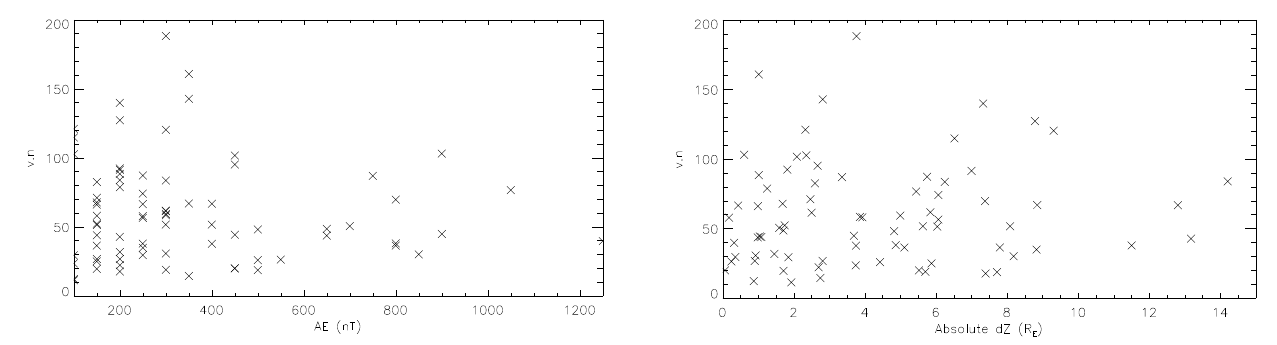
Fig. 17. The normal velocity component of the plasma sheet ex- pansions plotted against average AE conditions to test for substorm size dependence on the expansion normal velocity. The average substorm condition in this data set has an AE of ∼ 350nT. There exists no correlation with a Pearson’s product moment correlation coefficient of − 0.06.